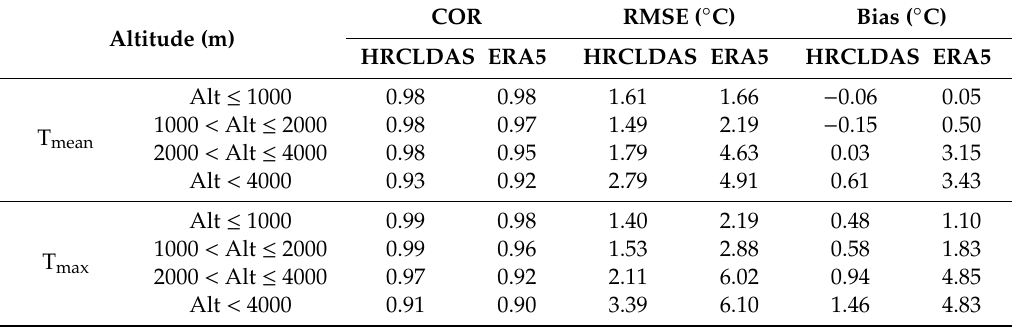
Table 2. The COR, RMSE and bias of daily mean temperature (T mean ) and daily maximum temperature (T max ) of HRCLDAS and ERA5 at di ff erent altitudes. COR RMSE ( ◦ C) Bias ( ◦ C) Altitude (m) HRCLDAS ERA5 HRCLDAS ERA5 HRCLDAS ERA5 Alt ≤ 1000 0.98 0.98 T mean